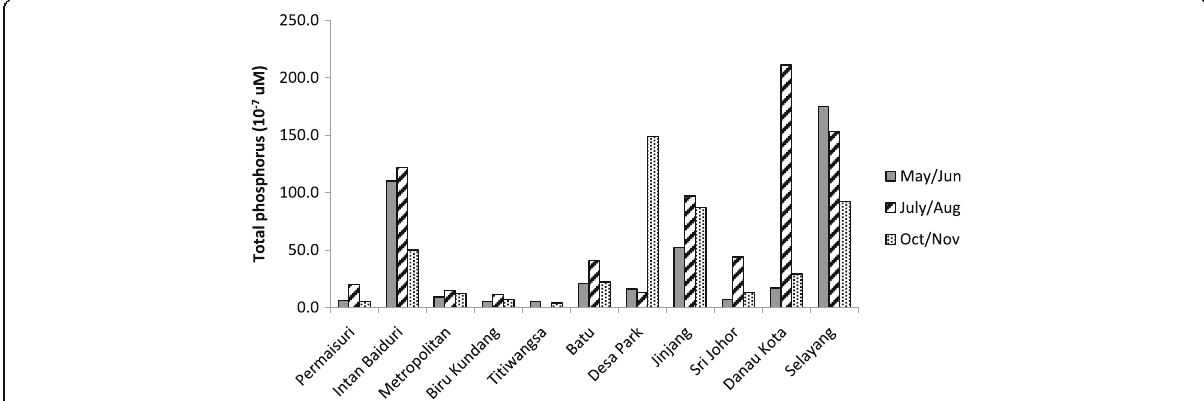
Fig. 1 Total phosphorus concentration (10 − 7 μ M) in studied lakes and ponds